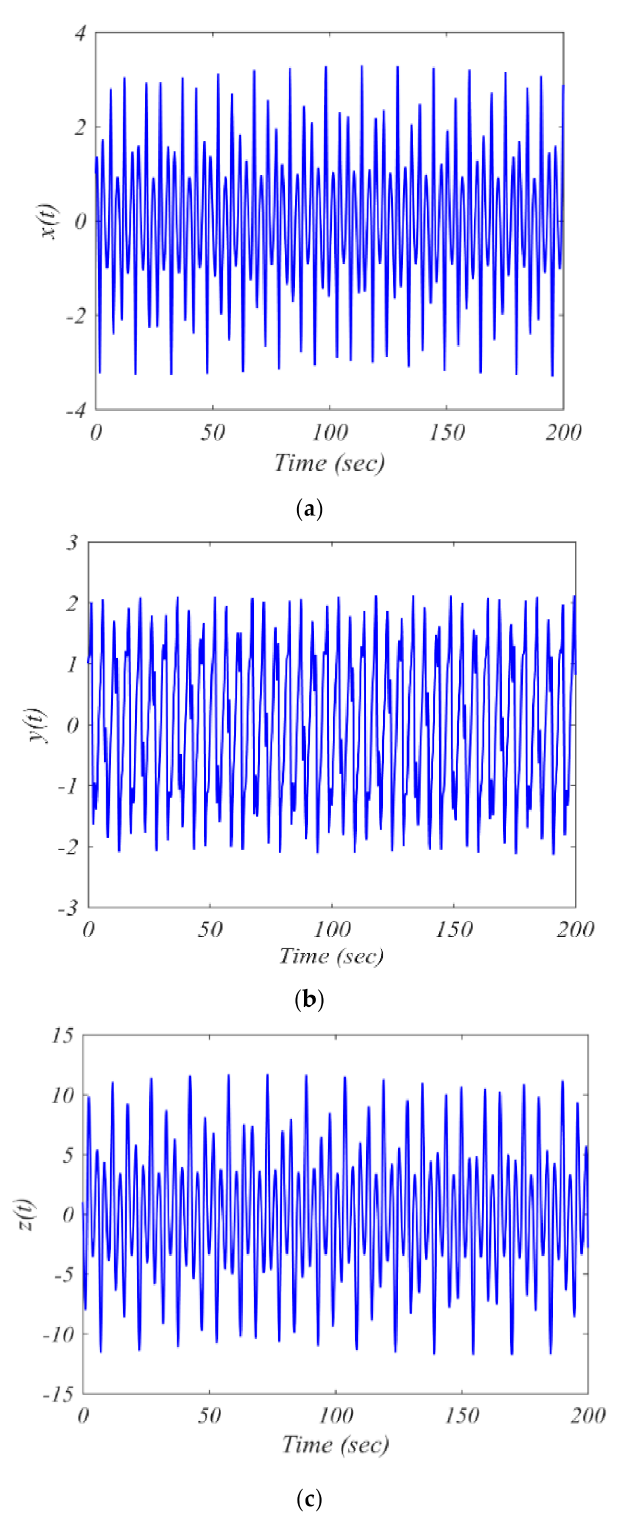
Figure 1. States time series of proposed system; ( a ) x ( t ); ( b ) y ( t ); ( c ) z ( t